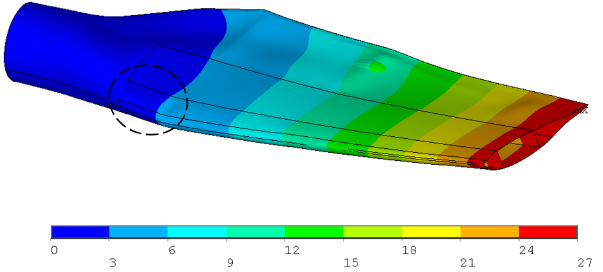
Figure 21. Total deformation occurring in the form of local de- formation due to failed elements at 309% edgewise (min) loading. (Scale factor for deformation plot: ×